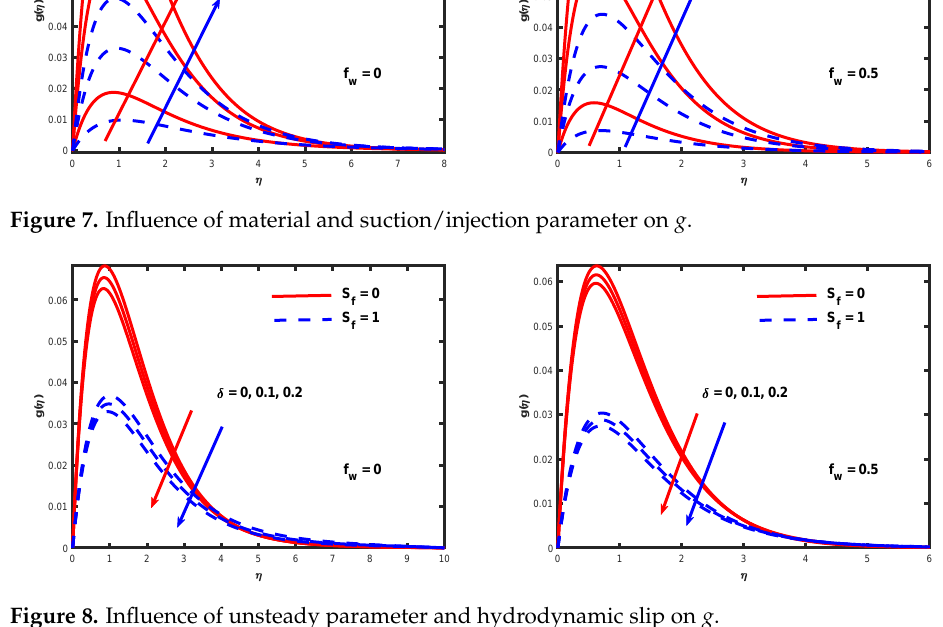
Figure 8. Influence of unsteady parameter and hydrodynamic slip on g .